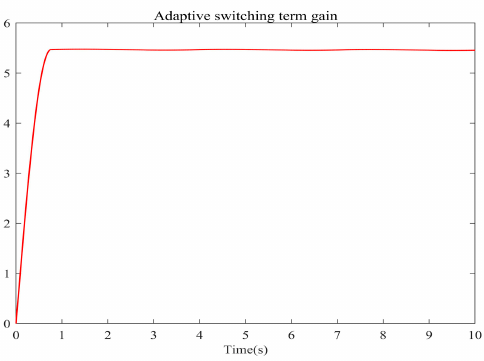
Figure 16. Observe error curves of LESO for system state and total disturbance in the inverted pendulum system.